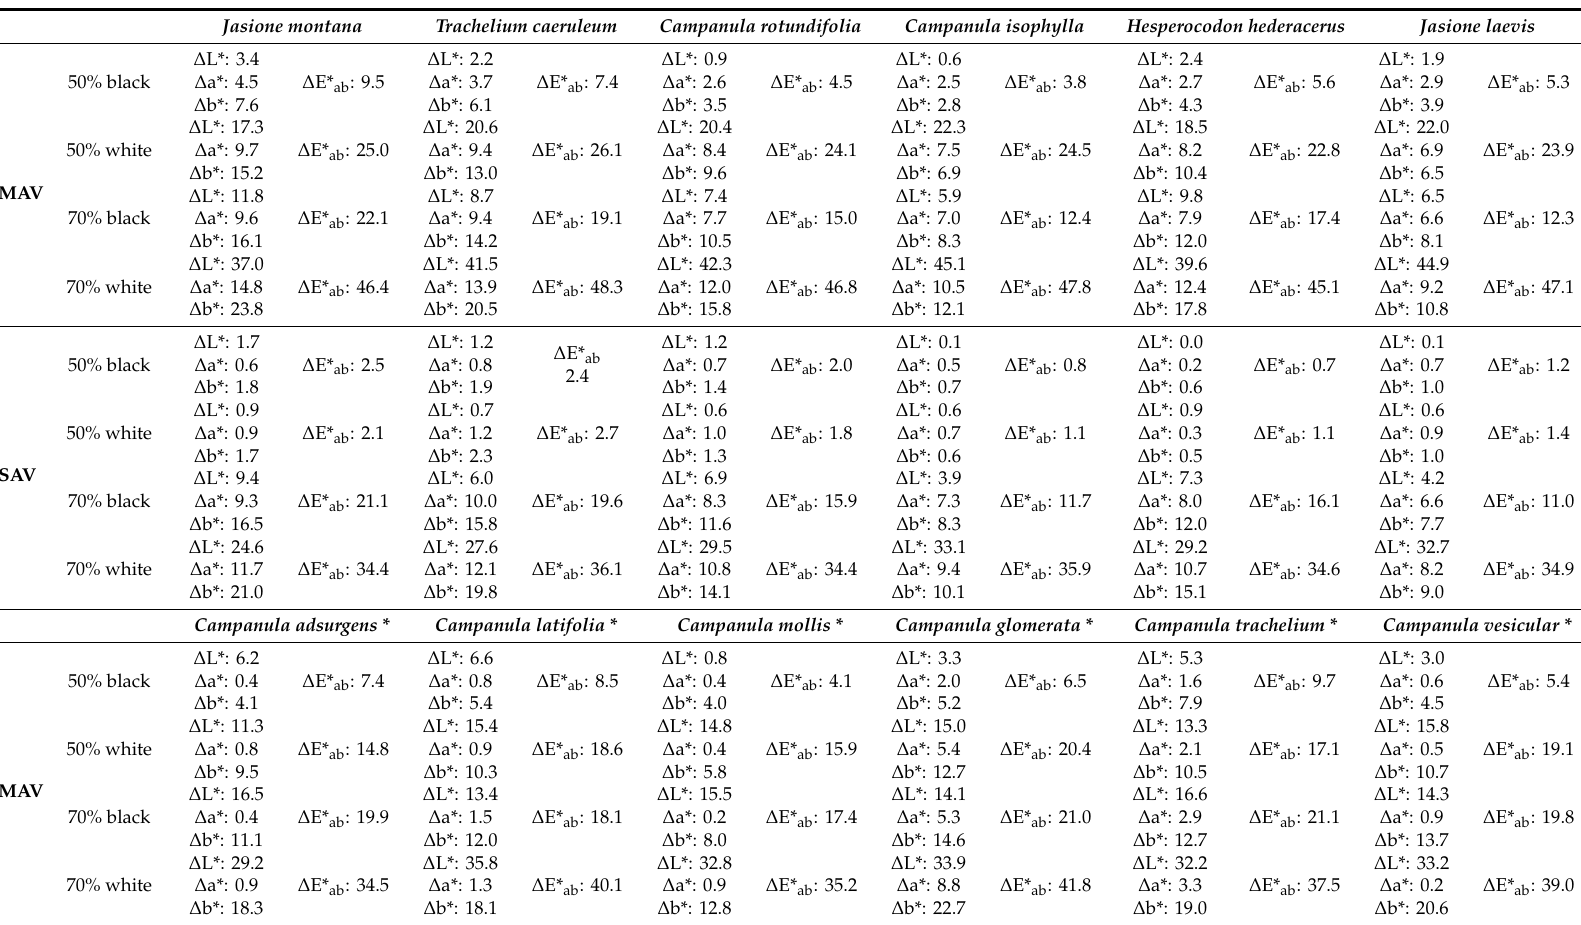
Table A1. Partial ( ∆ L*, ∆ a*, ∆ b*) and total ( ∆ E* ab ) color di ff erences in absolute values with black 50%, white 50%, black 70%, and white 70% adaptors compared to those obtained with no adaptor. Jasione montana Trachelium